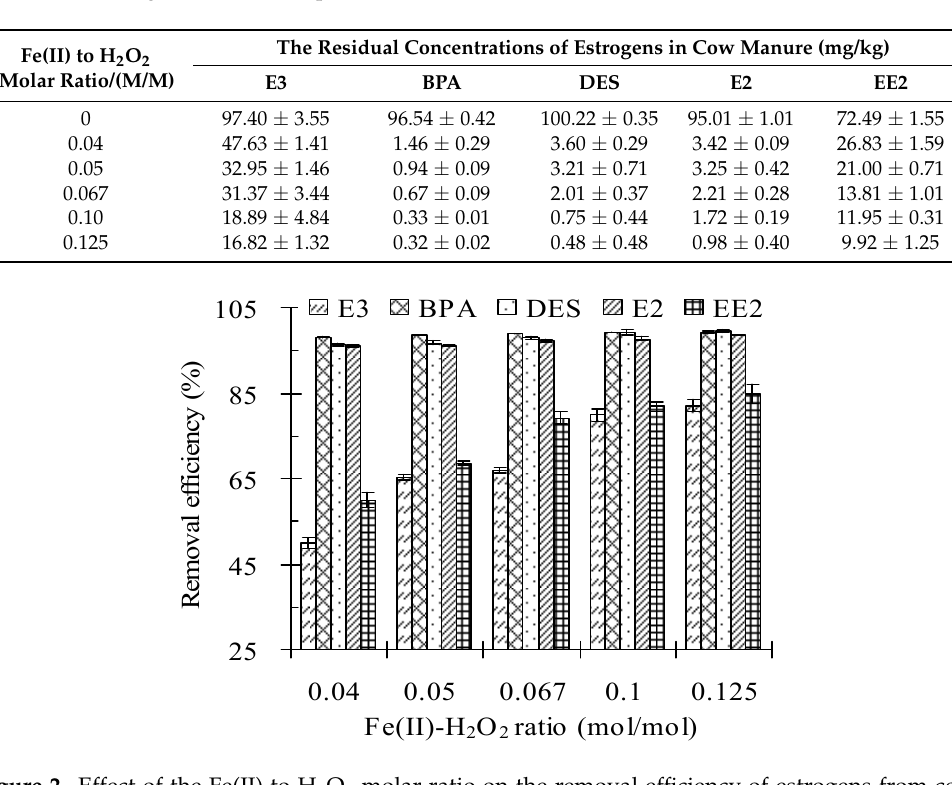
Figure 2. Effect of the Fe(II) to H 2 O 2 molar ratio on the removal efficiency of estrogens from cow manure by the Fenton oxidation process. Note: the H 2 O 2 dosage was 2.56 mmol/g; the solid to water mass ratio was 2 g/mL; the initial pH value was 3.0; the reaction time was 24 h. Error bars represent standard deviations.